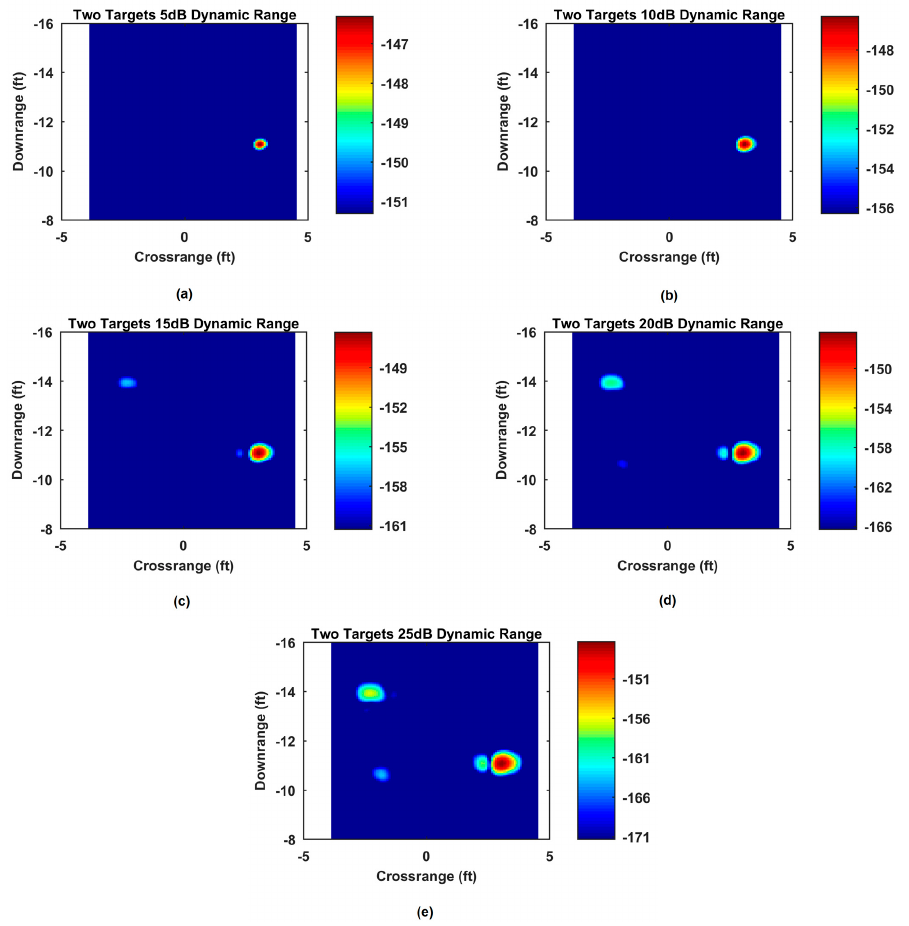
Figure 14. Fused images of multiple targets over 5–25 dB image dynamic range: ( a ) 5 dB; ( b ) 10 dB; ( c ) 15 dB; ( d ) 20 dB; ( e ) 25 dB.